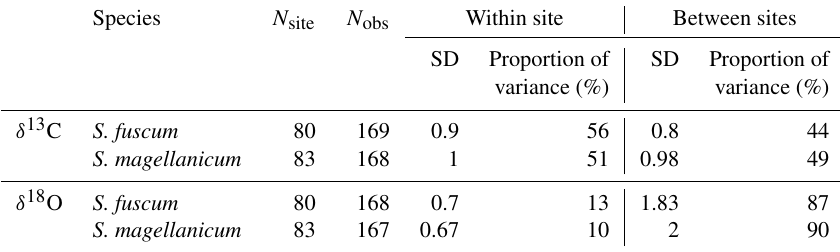
Table 1. Sample sizes, standard variation and overall partitioning of measured variation for each species and response ( δ 13 C and δ 18 O). N site is the number of sites and N obs the total sample size. Standard deviation of the responses is given for within and between sites, together with the proportion of total variance measured between sites and within sites. Species N site N